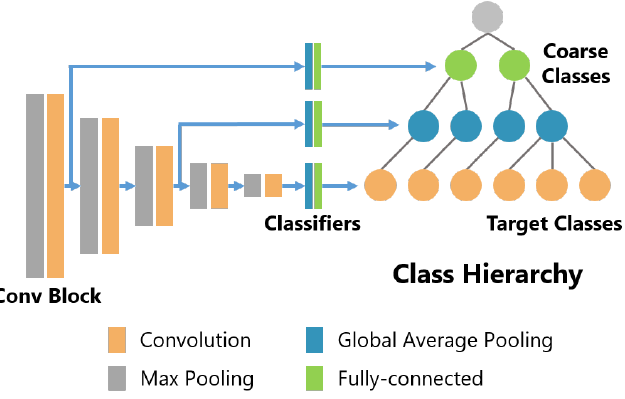
Figure 3. Model structure of the B-CNN with VGG16 as the base